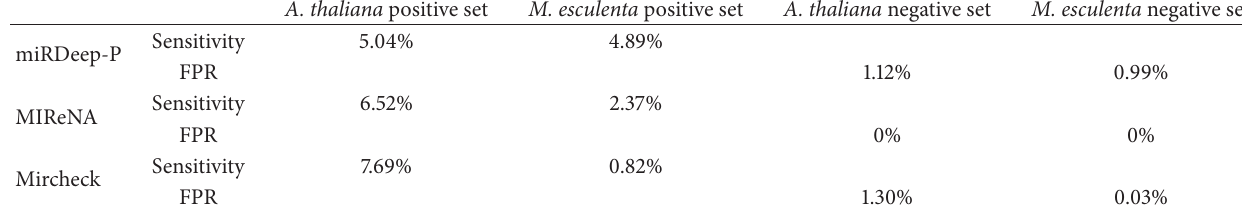
Table 1: Comparison of miRDeep-P, MIReNA, and Mircheck using default parameters. miRNAs predicted by each of the three methods were filtered using criteria described by Meyers et al. [12]. FPR: False positive rate.